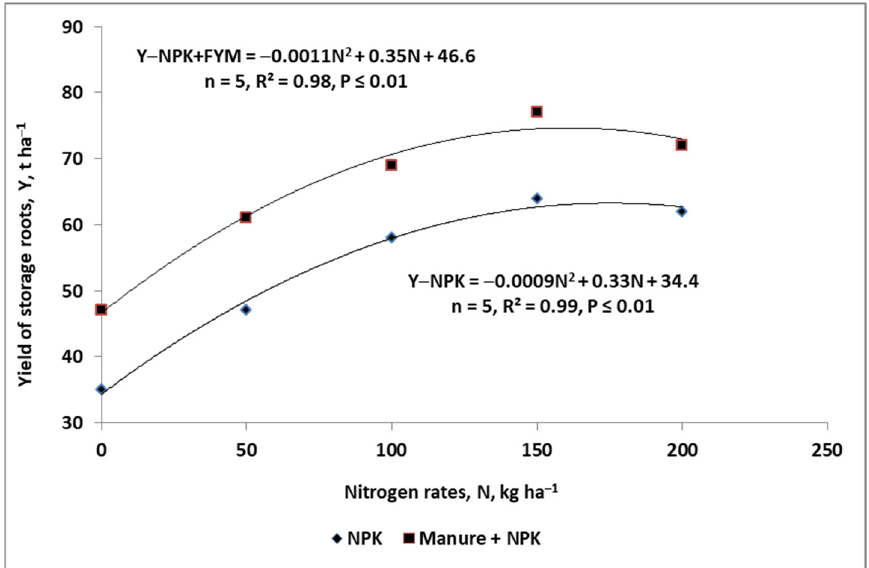
Figure 3. Sugar beet response to the interaction of nitrogen fertilizer rates with the constant rate of farmyard manure (based on W. Grzebisz non ─ published data). farmyard manure (based on W. Grzebisz non–published